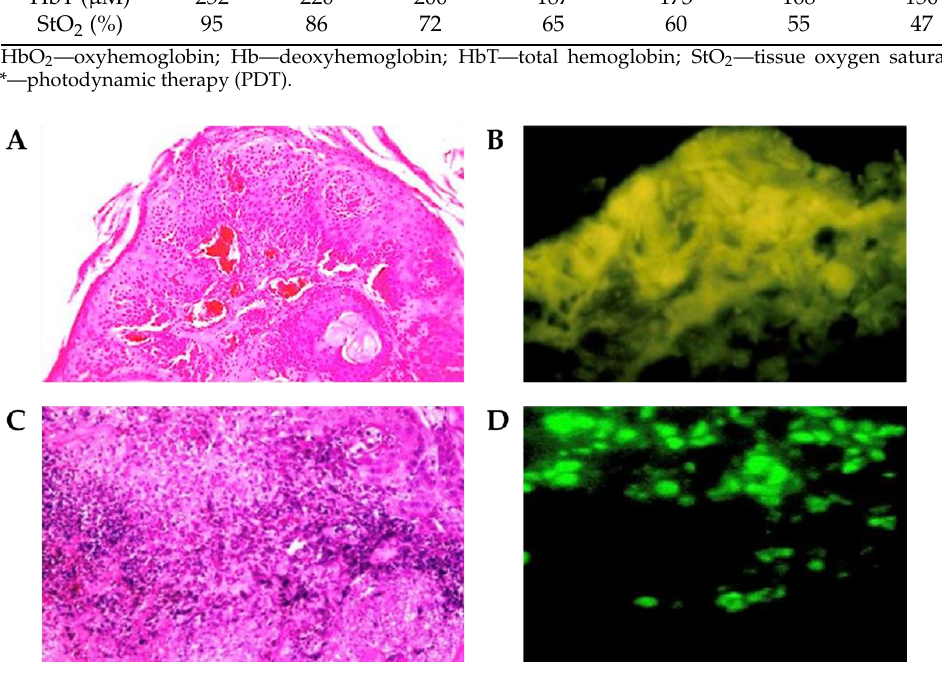
Figure 4. The histopathological findings and fluorescent images (100×) of stimulated squamous cell carcinoma on the buccal mucosa of hamsters ( A , B ) were identified. Severe internal hemorrhage and red blood cell extravasation with the destruction of the tumor 12 h after PDT were demonstrated ( C , D ) (200×). Table 1. Mean changes in intrinsic signals based on time during tumor growth.